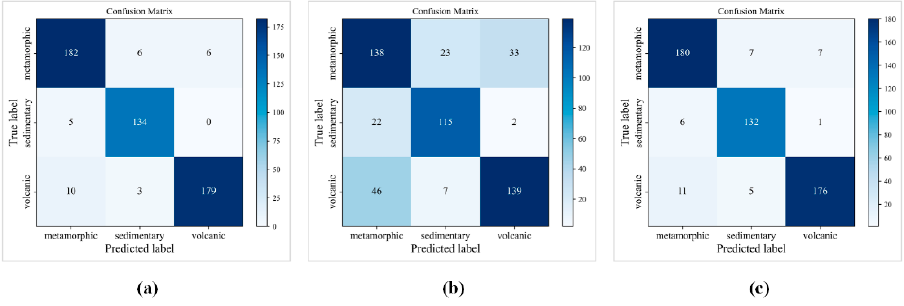
( d ) Figure 23. ( a ) Training loss of ShuffleNetV2 under three optimizers; ( b ) results of metamorphic rock